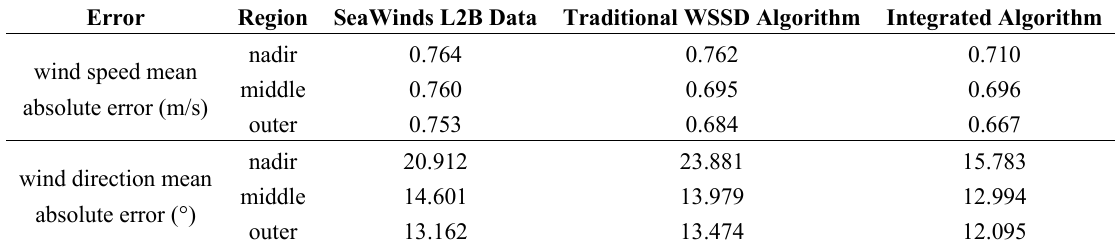
Table 1. The retrieval errors for each region of the swath.